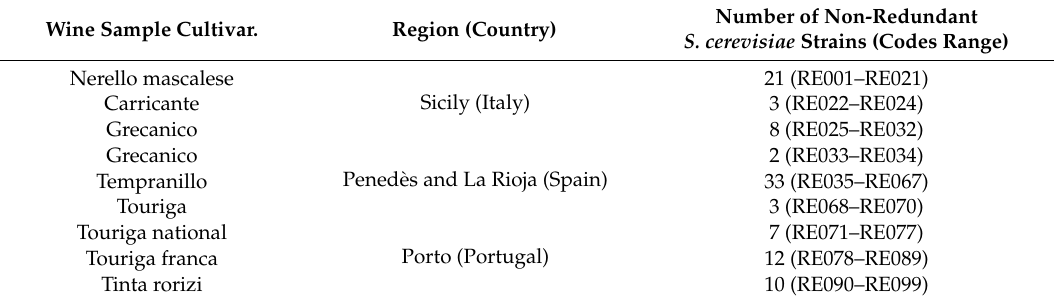
Table 1. Origin of the 99 S. cerevisiae strains used in the present work. Wine Sample